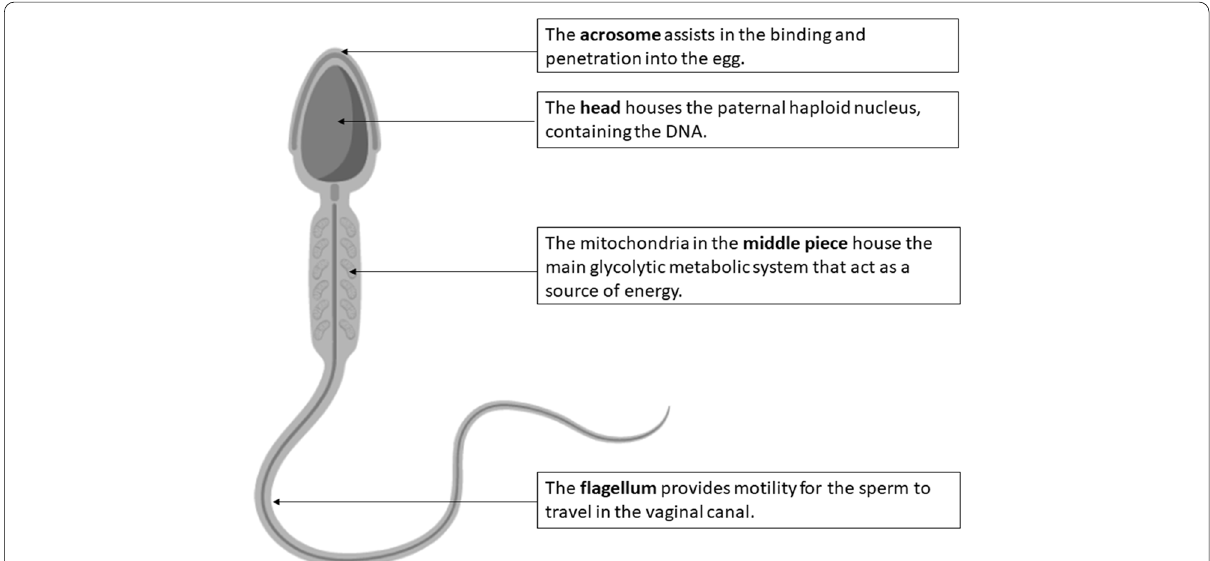
Fig. 2 Sperm cells essentially have four core elements: (1) a paternal haploid nucleus containing the DNA; (2) a mitochondrial and glycolytic metabolic system that act as a source of energy; (3) a motor (the flagellum) providing motility for the sperm to travel in the vaginal canal; and (4) a mechanism that assists in the binding and penetration into the egg (the